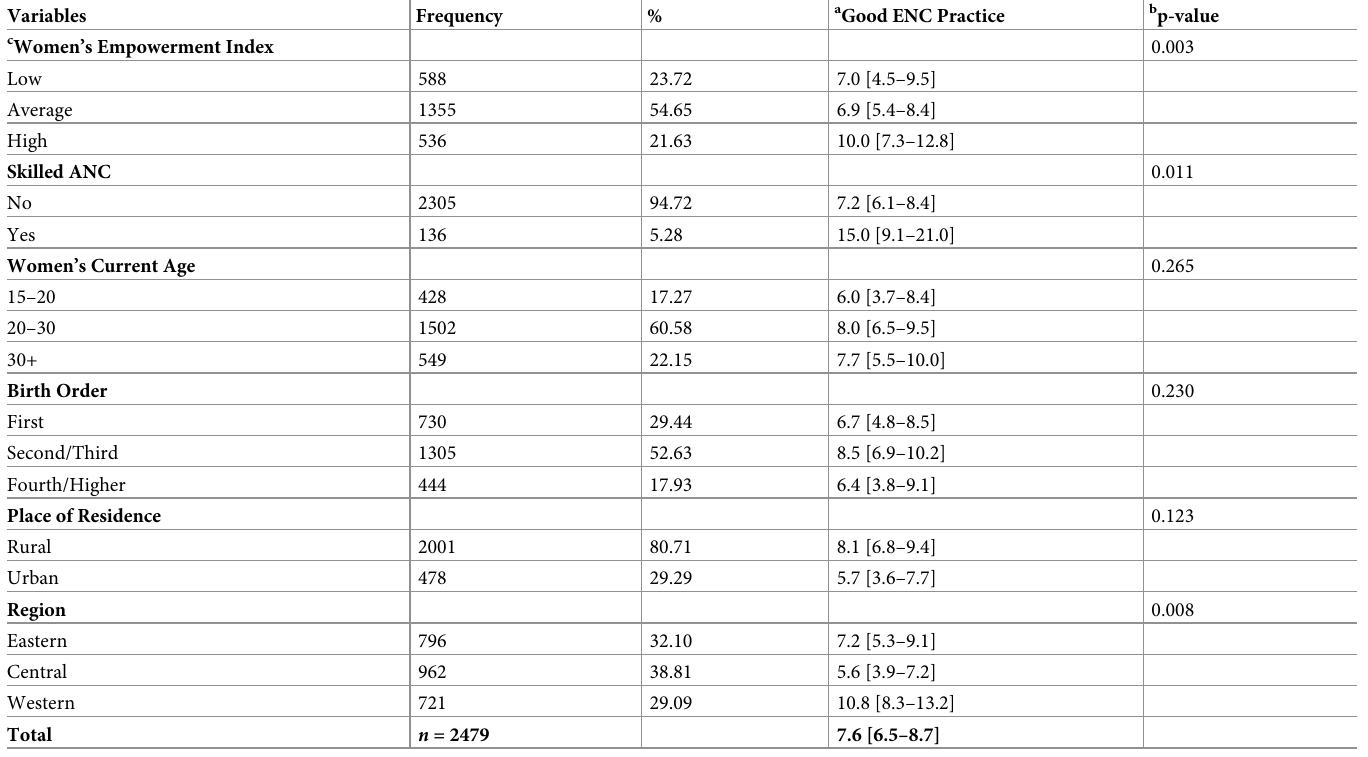
Table 2. Percentage distribution of covariates and prevalence of good ENC for home births in Bangladesh.